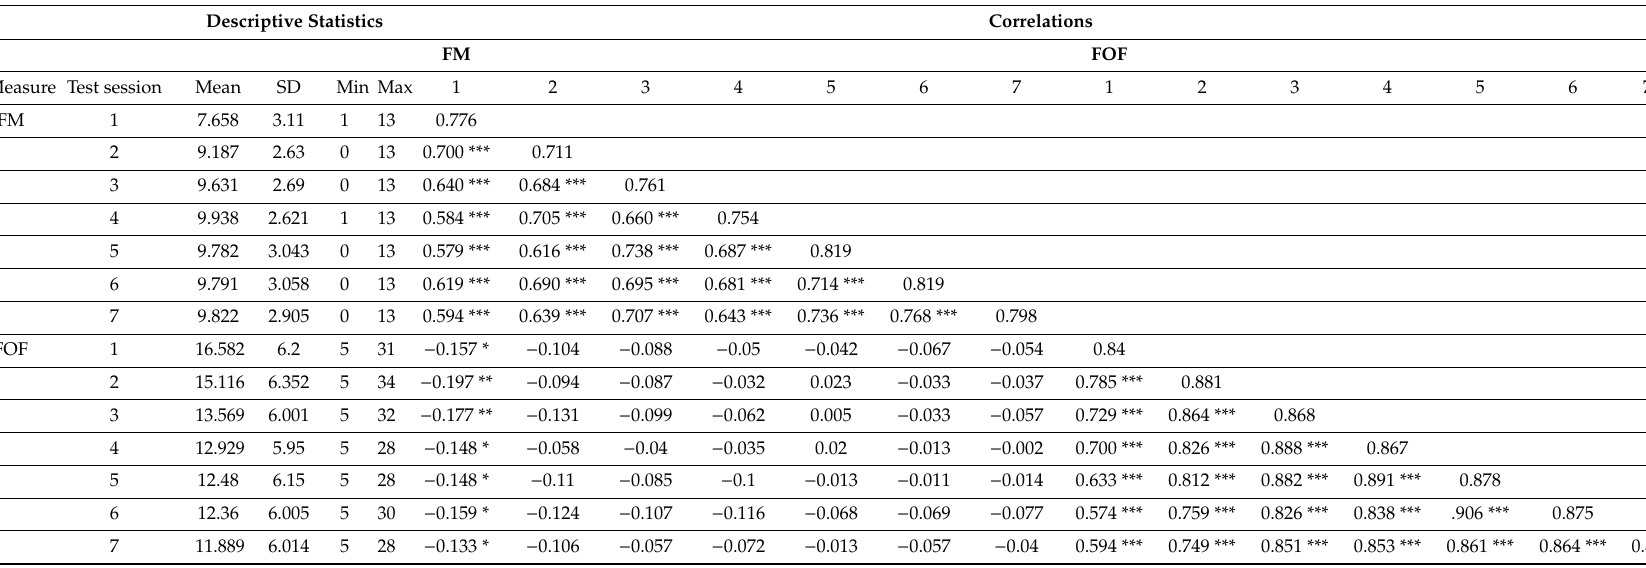
Table 1. Descriptive statistics and correlations of study variable sum